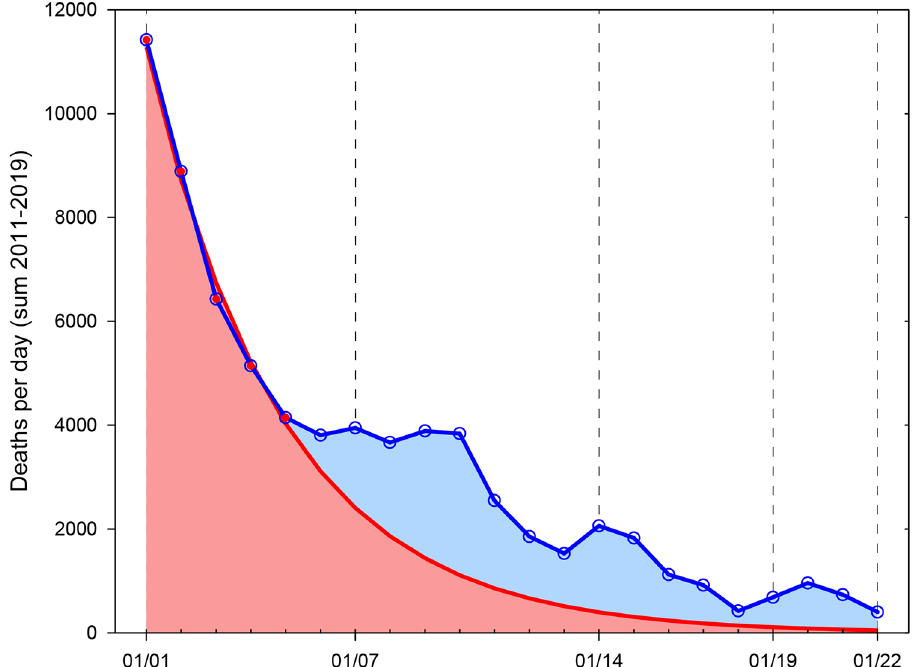
Fig. 3. Structure of excess deaths on January 1–22, depending on the holiday, sum of indicators for 2011–2019. Note: The blue line shows the dynamics of the total number of deaths, the red line is the exponent plotted for January 1–5 (days are marked with red dots on the line). The red field is excess mortality due to the New Year, the blue field is excess mortality due to the other three holidays. The moving average LOWESS is taken as the zero mark on the ordinate axis. Source: authors’ calculations based on modelling and Rosstat